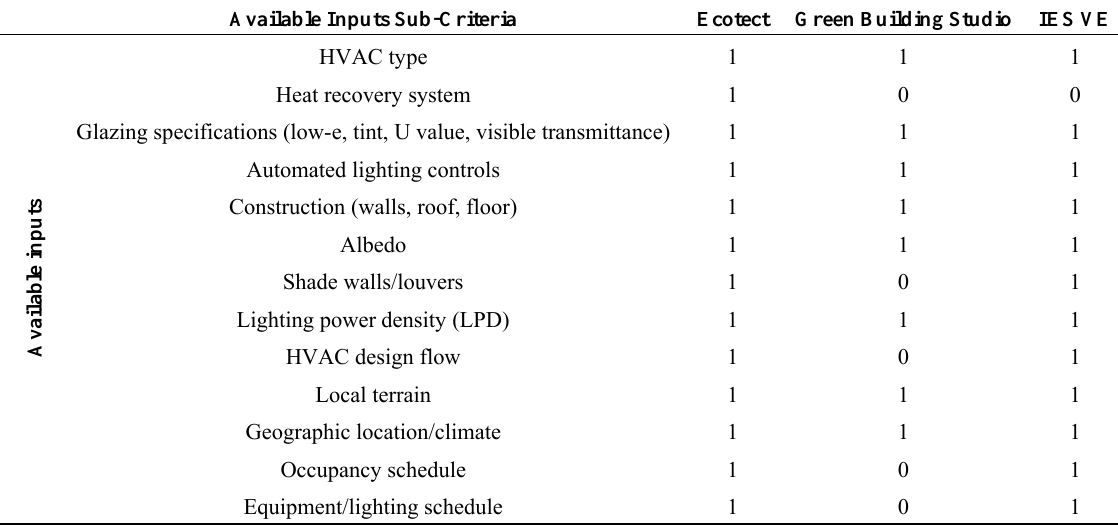
Table A9. Re-evaluation: available inputs criterion calculations for the top three BEM tools. Available Inputs